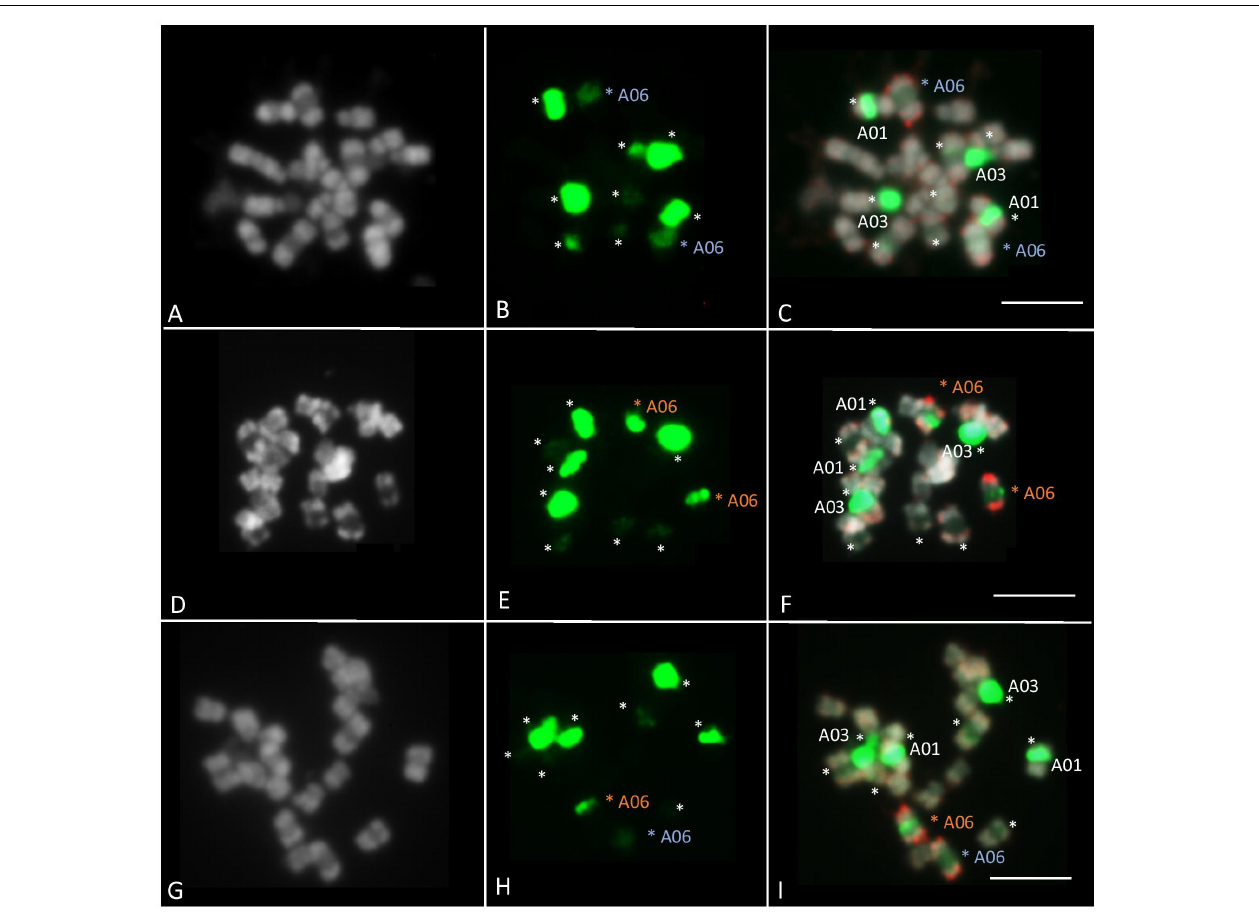
FIGURE 5 | Fluorescent in situ hybridization was carried out using 45S rDNA (in green) and KBrB022P06 + KBrH003P24 BAC probes (A06) (in red). FISH analyses of somatic metaphase chromosomes were carried out in B. rapa ‘Z1’ (A–C) , B. rapa ‘Chiifu’ (D–F) , and hybrid ‘Z1’ × ‘Chiifu’ (G–I) . The 45S rDNA probe on B. rapa marked five different chromosome pairs (stars). A06 chromosomes carrying 45S rDNA were indicated by a blue star in ‘Z1’ and an orange star in ‘Chiifu.’ Chromosomes were counterstained with DAPI (gray). Bars represent 5 µ